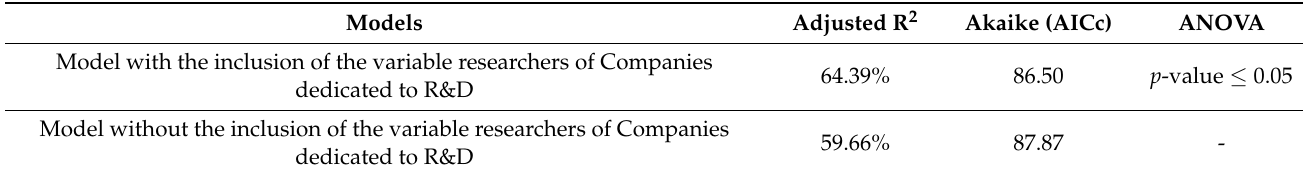
Table 3. Analysis of the contribution of the variable Researchers of Companies dedicated to R&D to the Regression model.